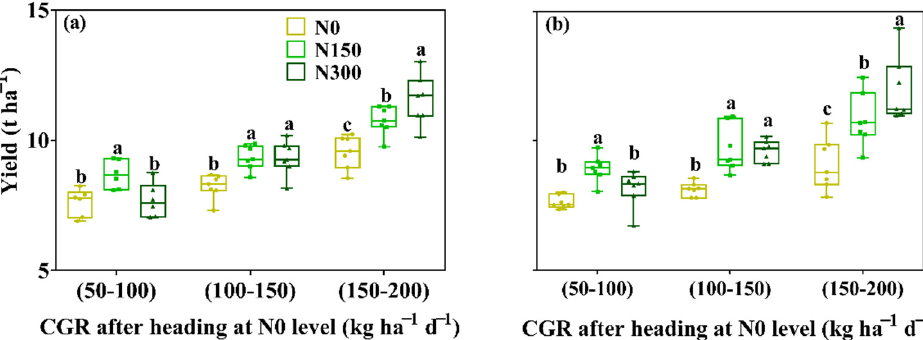
Figure 10. Yields of three subsets of indica hybrids (IHs) based on CGR after heading at N0 level in 2017 ( a ) and 2018 ( b ), respectively. Different lowercase letters above the columns indicate statistical significance at the p < 0.05 level among different nitrogen levels.